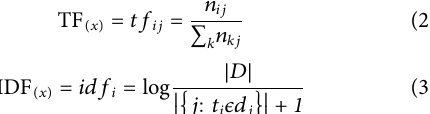
Figure 5. Based on drawing lessons from previous research on scales of low-carbon awareness (Liu and Ji, 2019), low- carbon cognition (Tang et al., 2018), and environmental